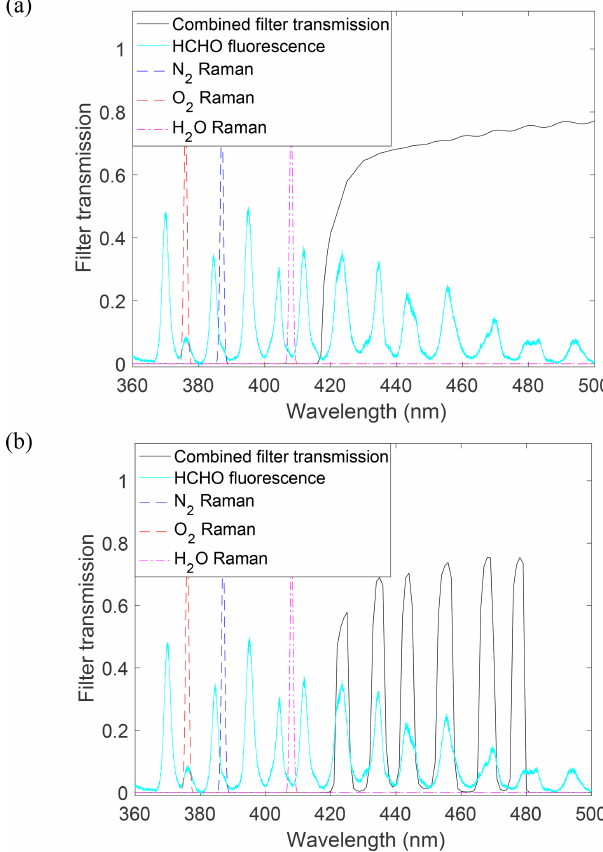
Figure 3. The combined optical filter transmission spectrum for (a) detection Axis 1 and (b) detection Axis 2. HCHO fluorescence and N 2 , O 2 , and H 2 O Raman spectra are shown with arbitrary units. The Raman spectra are for the first Stokes Q branch only and are intended to give a general sense of the transition wavelengths. Fil- ters transmit approximately 19% and 34% of the fluorescence for Axis 1 and Axis 2,